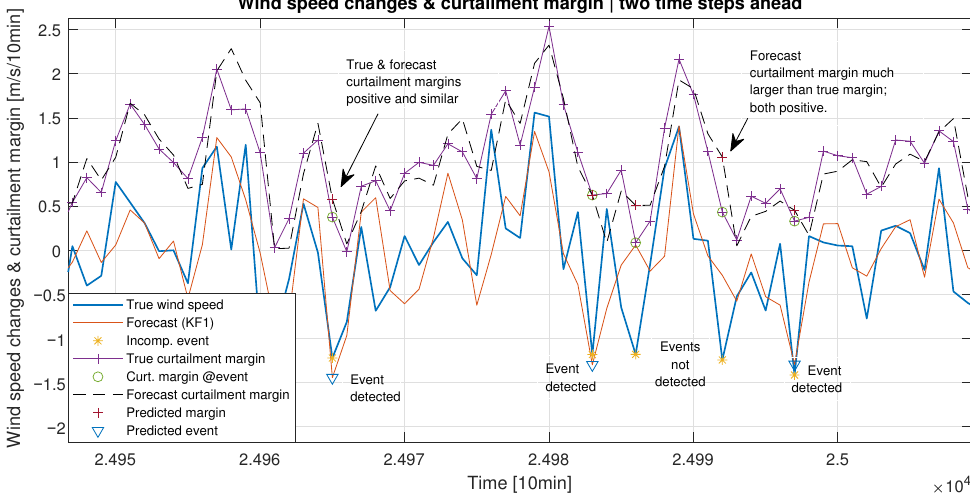
Figure 6. Example time series of the true wind speed changes, the forecast wind speed changes, as well as the true and the forecast curtailment margins, all for two time steps into the future, shown for methods KF1 and KF4; see Table 2. The critical slope was set to a = 1 m/s in this